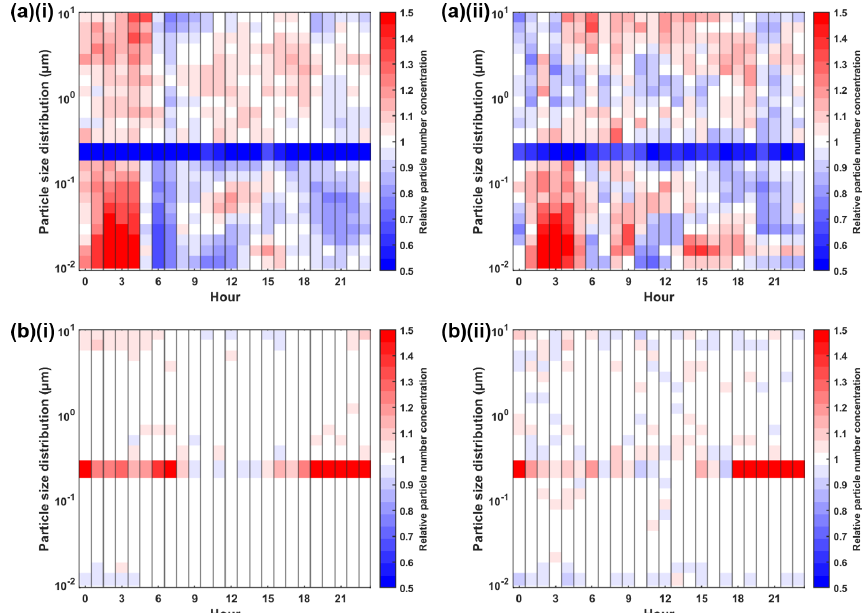
Figure 10. Heat map showing the hourly median relative particle number concentration of the approach with (a) meteorological parameters (approach 1, FFNN–met) and (b) particle size distribution (approach 2, FFNN–PSD) as inputs across different hours of a day (i) on workdays and (ii) on weekends. The relative particle number concentration is defined as the estimated concentration with respect to the measured concentration. Red colour shows overestimation while blue shows